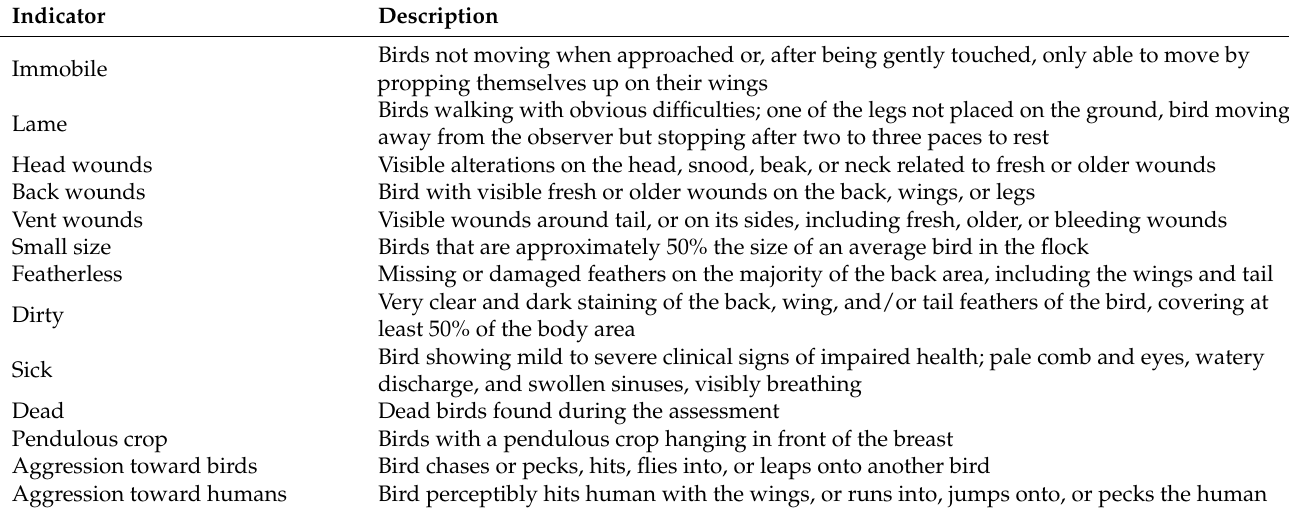
Table 3. Description of the birds’ behavior and appearance in each of the welfare indicator categories. Indicator